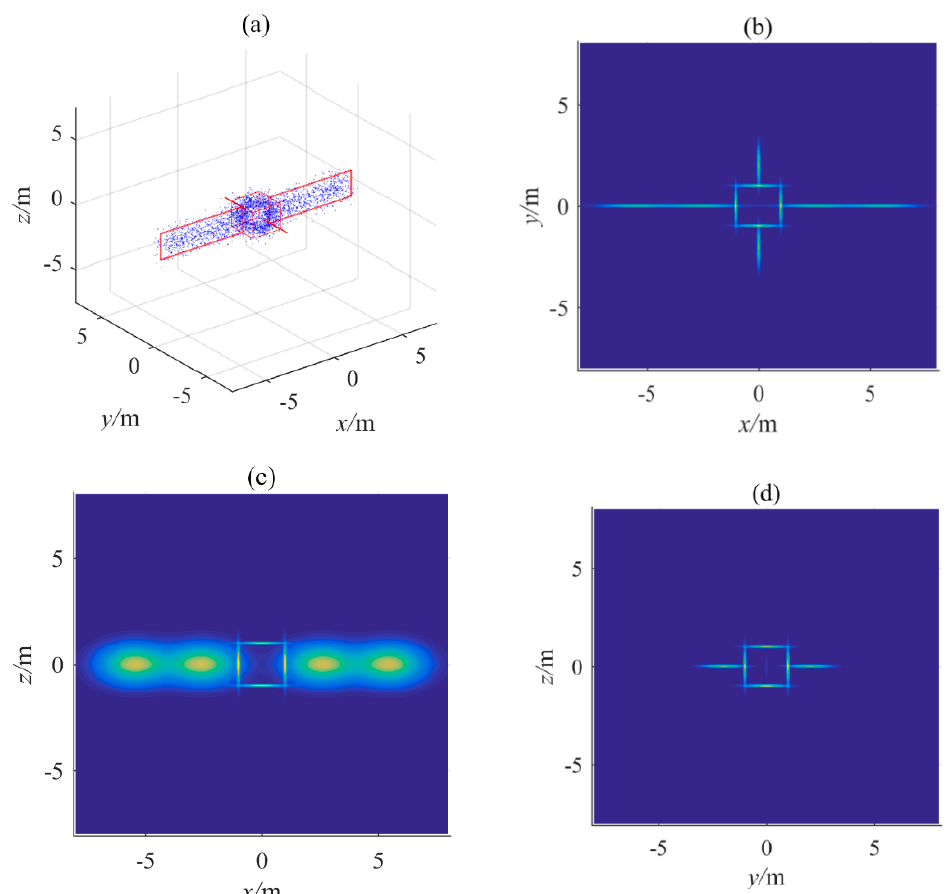
Figure 4. The GMM-based reconstructed point-cloud and potential distribution. ( a ) Reconstructed point-cloud of the target shape; ( b ) the projection of GMM-based potential distribution in x-O-y plane; ( c ) the projection of GMM-based potential distribution in x-O-z plane; ( d ) the projection of GMM-based potential distribution in y-O-z plane.